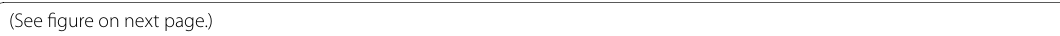
figure on next Fig. 4 Analysis of PSII and PSI activity. a Light response curve of rETR(II), the relative electron transport rate of PSII. b O 2 evolution rate under 300 μmol photons m − 2 s − 1 . c Light response curve of rETR(I), the relative electron transport rate of PSI. The cells grown under HC and measurements were done at LC conditions. Error bars indicate standard deviations (SD) of the data from three independent experiments. For each experiment, three technical replicates were